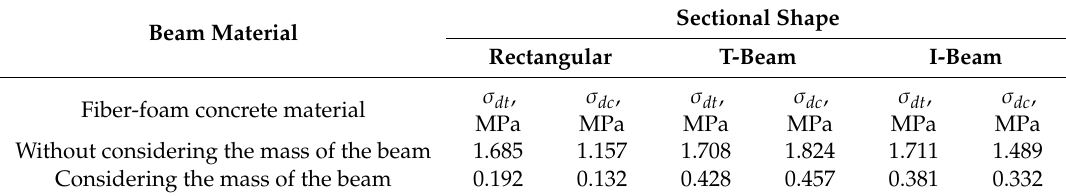
Table 1. Maximum dynamic stresses in beams of rectangular, T- and I-shape, considering bimodularity.